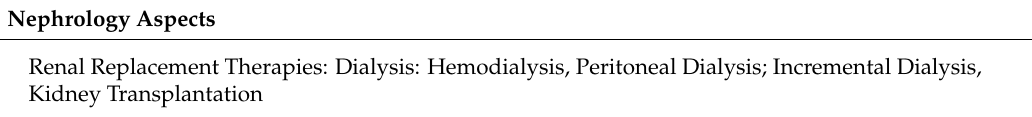
Table 1. Multidisciplinary Approach to Geriatric ESRD